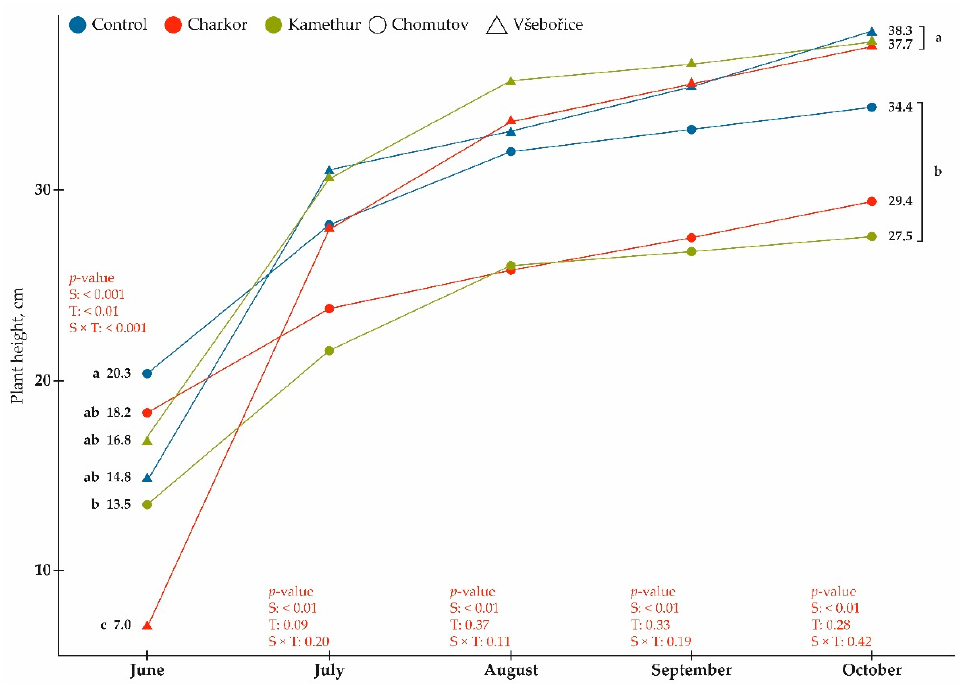
Figure 2. The growth dynamic of M×g during cultivation in Chomutov and Všebo ř ice soils. S–soil; T–treatment. Different letters within one month indicate a significant difference between the values. PGRs differently impacted the number of shoots (Table S1). At the beginning of the vegetation period (June 2021), Kamethur increased the value by 245% in the Chomutov soil; at the end of the vegetation period (October 2021), the number was the same as for the control (Table S2). In the Všebo ř ice soil, at the beginning of the vegetation period, the number of shoots with Kamethur was equal to the control and decreased by 43.5% at the end (Table S2).